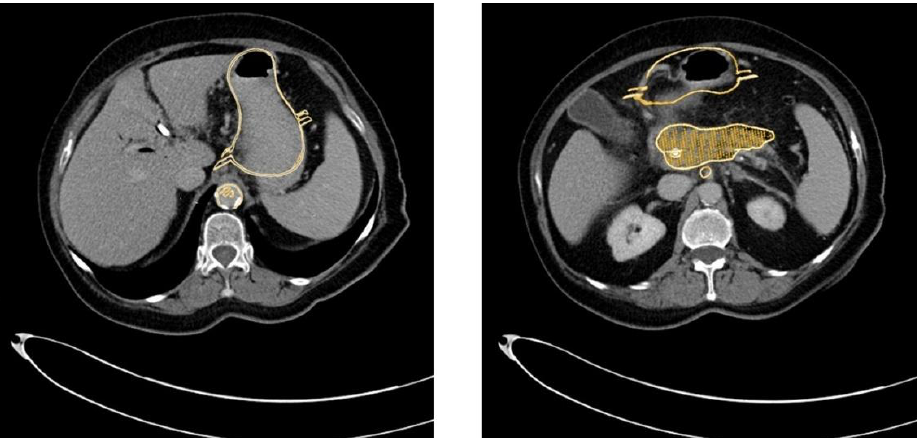
Figure 9. Overlay of the CT scan and the 3D-printed model (golden) and the original patient’s CT scan, demonstrating the high congruency between the replica and the original data.